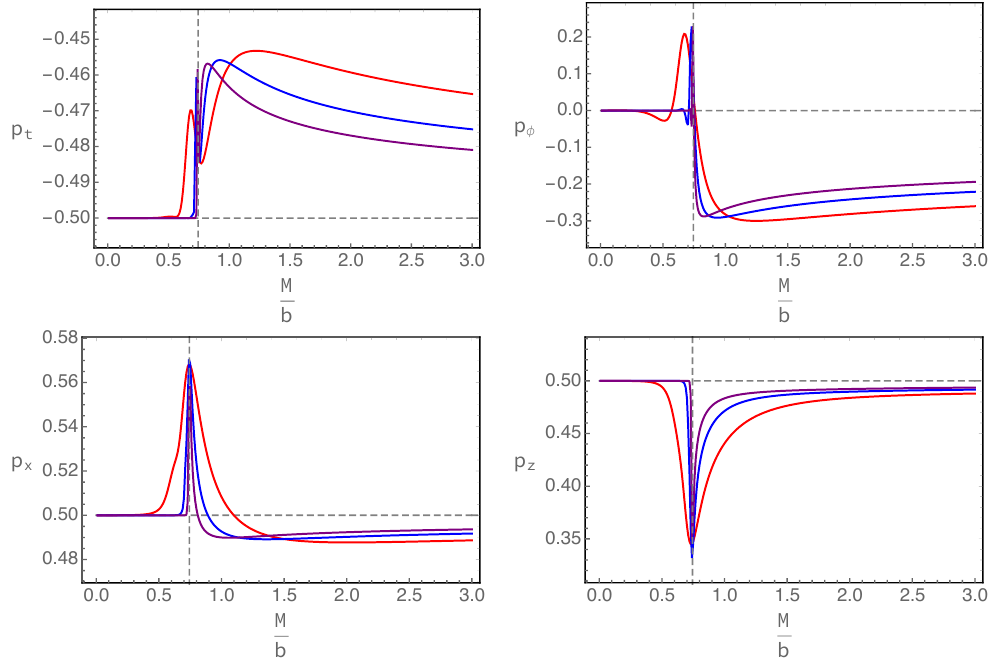
Figure 3 . Plots of Kasner exponents as a function of M/b . For all cases we have T/b = 0 . 05 (red), 0 . 02 (blue), 0 . 01 (purple). The dashed gray vertical lines are the Kasner exponents of five dimension Schwarzschild black